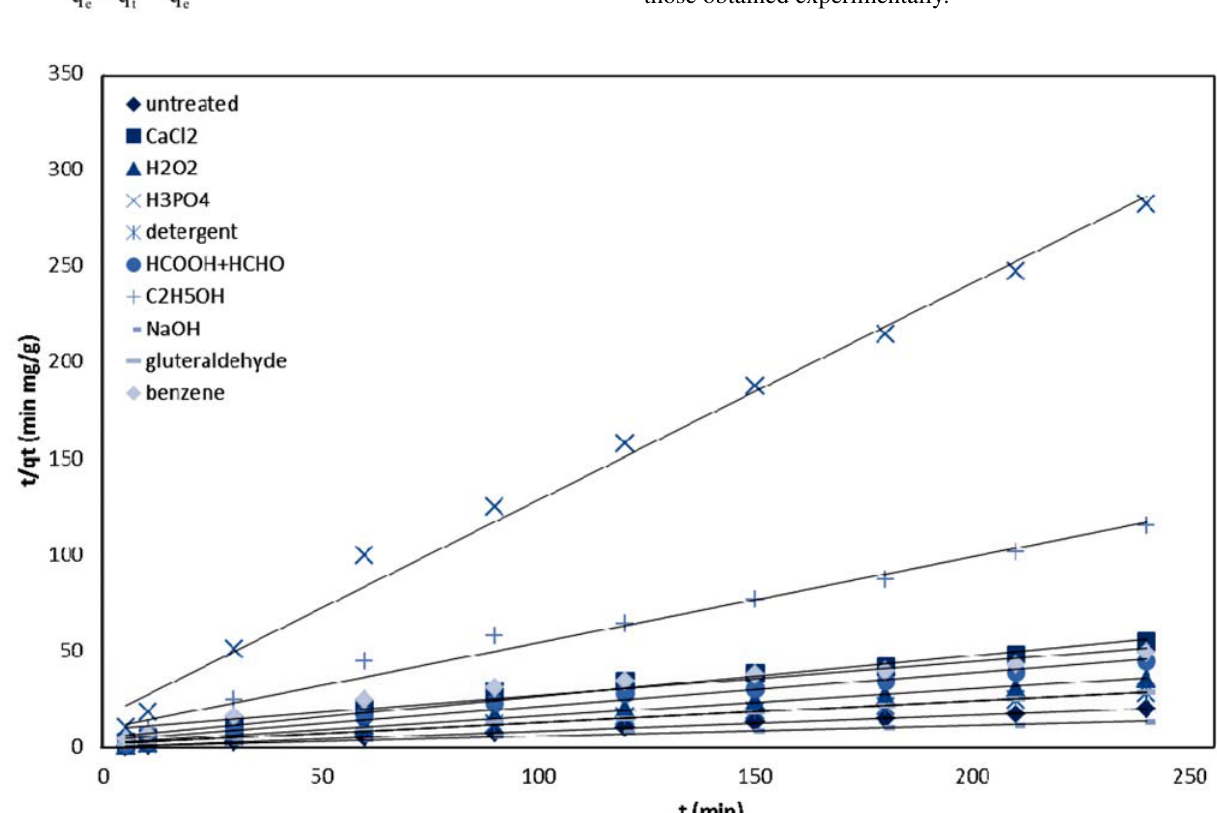
= 45 mg/L, 0.1 g/100 ml (dry i